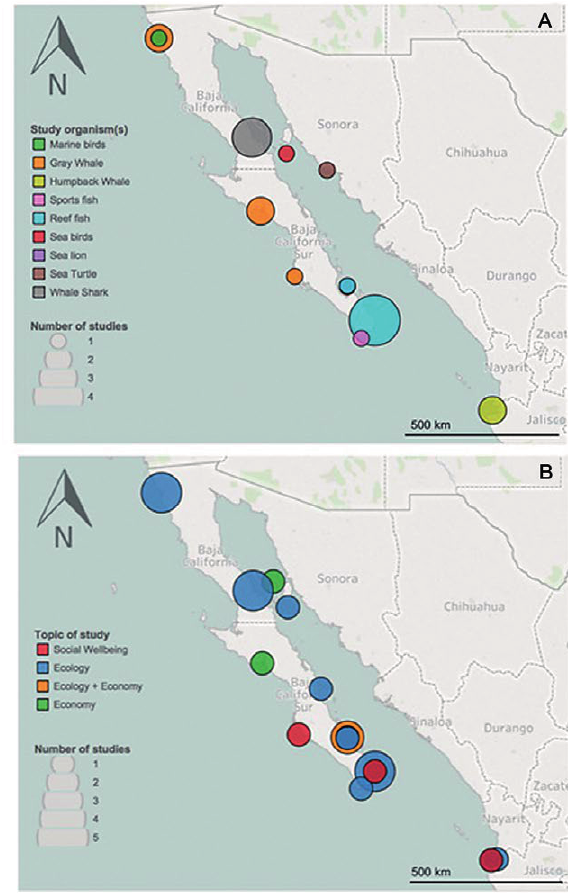
Fig. 4. – Approximate locations of studies on (A) species-specific studies and (B) studies that focus on ecology, economy or human social wellbeing for the Gulf of California and Baja California re- gion. The size of the bubbles represents the number of studies at each